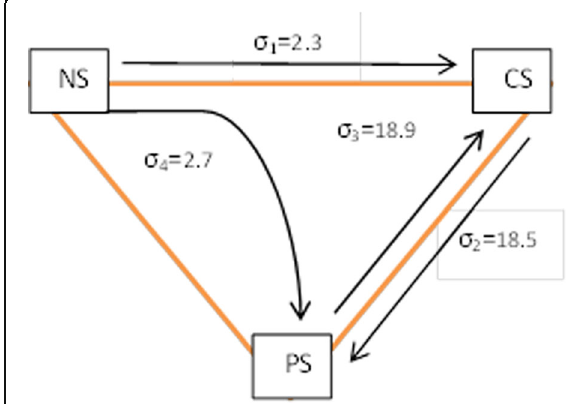
Fig. 4 Probability of transition (%) in smoking stages during the 5-year period in the population of 40 – 69 years, Shahroud, Iran